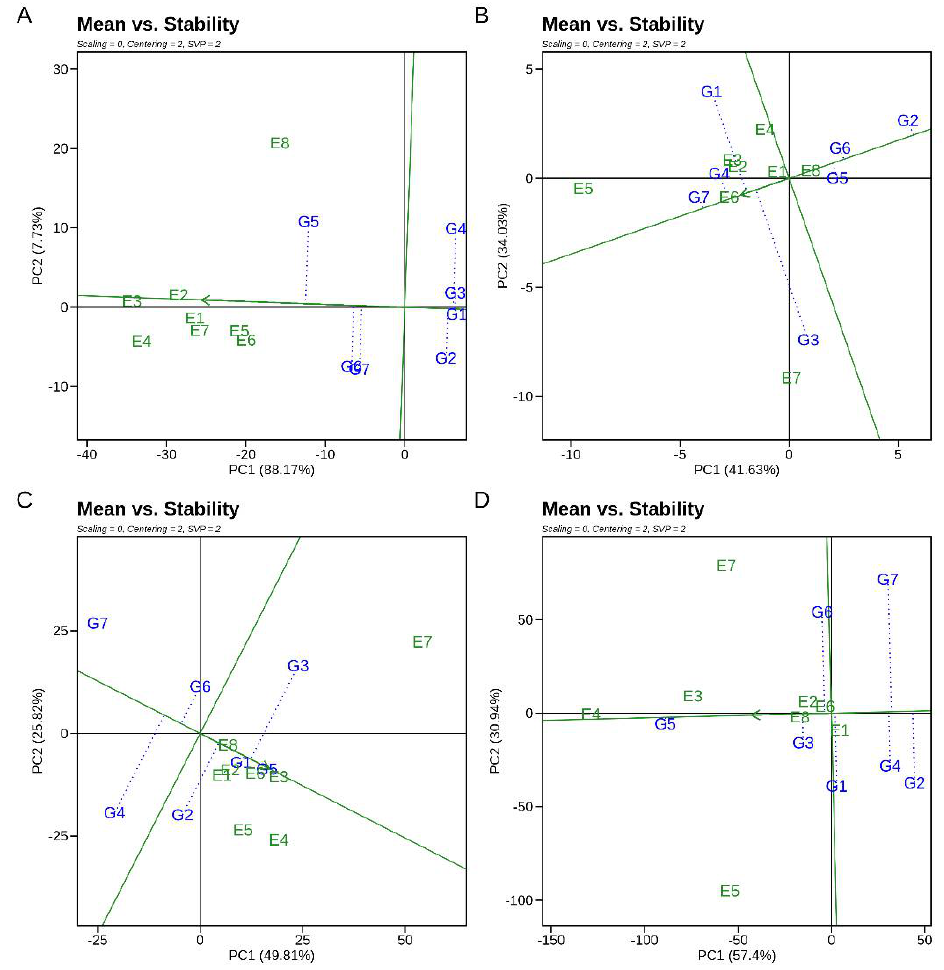
Figure 1. The GGE biplot ‘Mean vs. stability’ pattern of genotype × environment interaction of 5 GSR lines and 2 control lines grown under eight environments in the year 2020 for ( A ) plant height, ( B ) the number of tillers, ( C ) grain yield, and ( D ) straw yield. The biplots were created with cent− ering 0, SVP = 2, and scaling = 0 parameters.